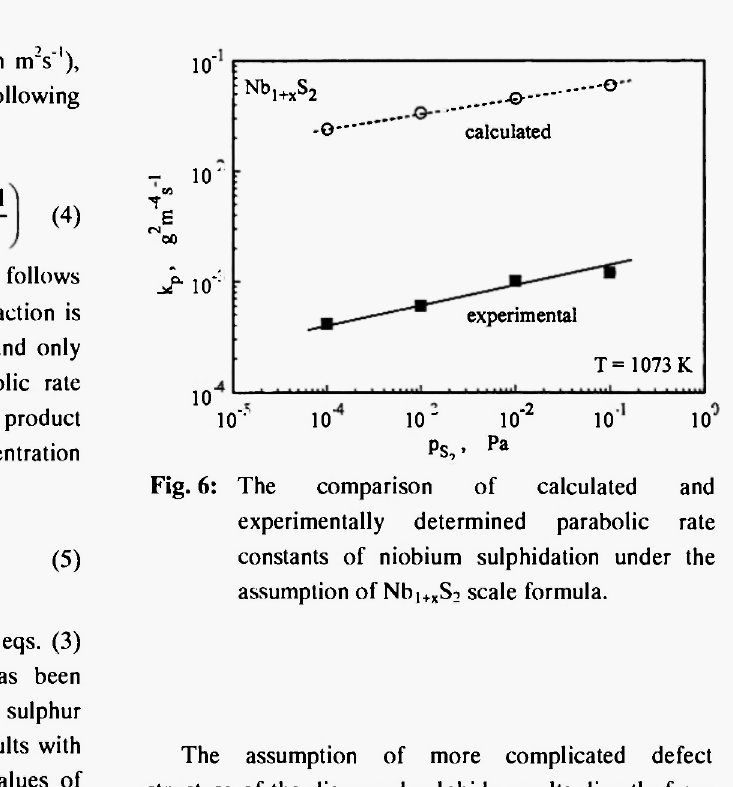
The assumption of more complicated